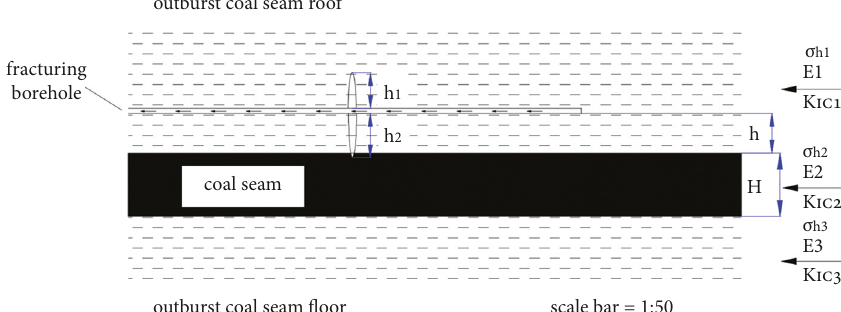
Figure 3: Symmetrical hydraulic fracture propagating in the roof of the outburst coal seam.